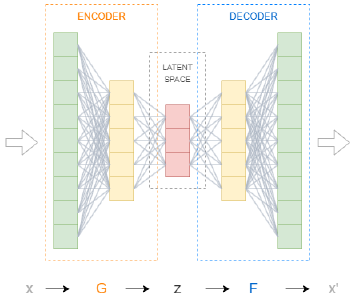
Figure 2. General example of an autoencoder with a three-dimensional latent space. Network G is an encoding function z = G ( x ) , where x is the model input, and z are named latent variables. The decoder F is defined to reconstruct the encoded signal, x (cid:48) = F ( z ) . The set of weights for both networks is simultaneously learned by minimising a loss function (cid:101) = d ( x , x (cid:48) ) according to some distance